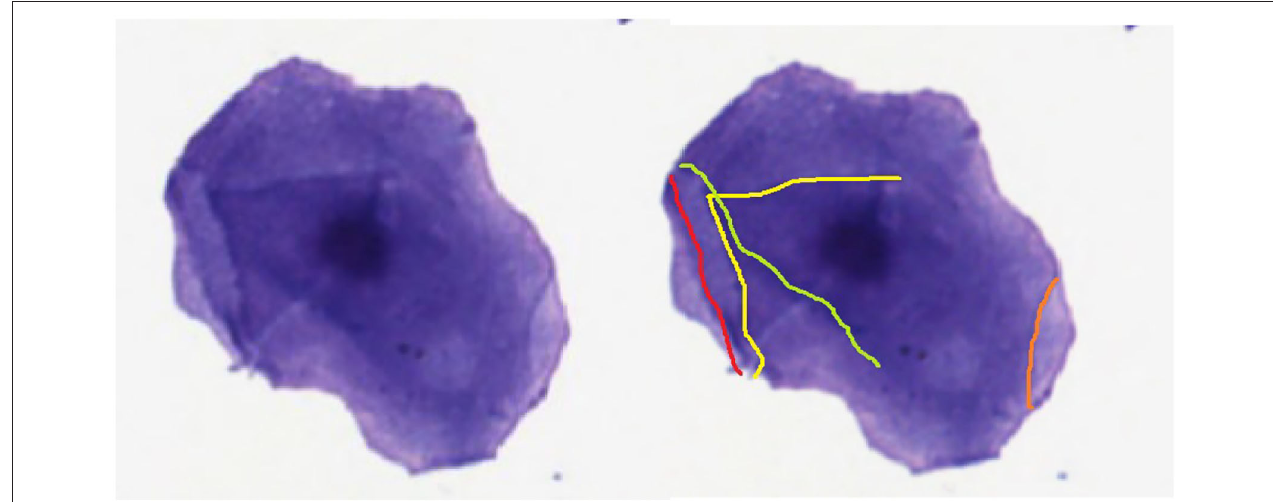
FIGURE 3 | Cornification lines of a vaginal epithelial